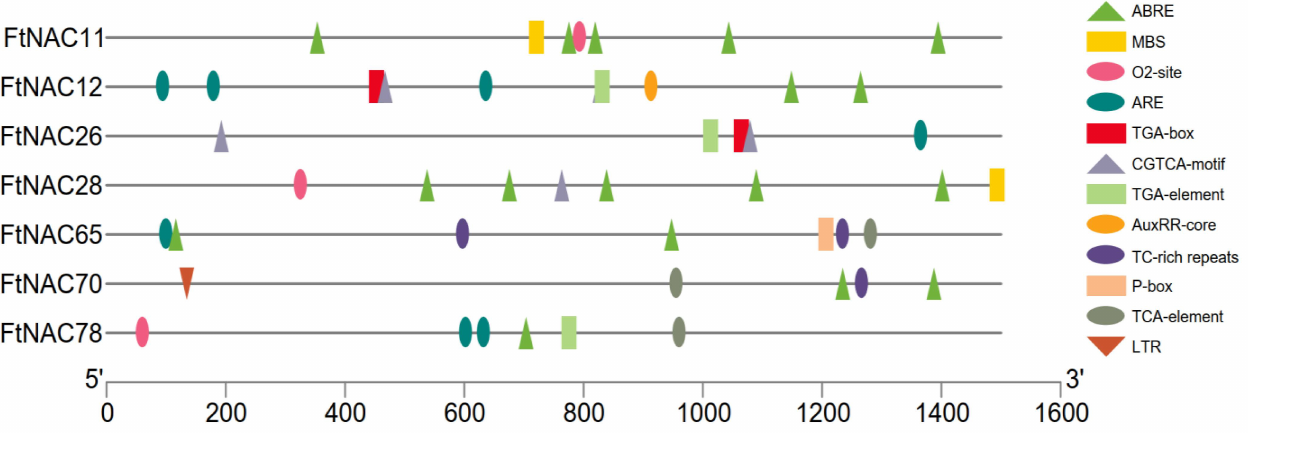
Figure 3. CARE Analyses of Seven FtNAC Promoters. ABRE, CARE involved in the ABA respon- siveness; MBS, MYB-binding site involved in drought-inducibility; O 2 -site, CARE involved in zein metabolism regulation; ARE, CARE essential for the anaerobic induction; TGA-box, part of an auxin- responsive element; CGTCA-motif, CARE involved in MeJA-responsiveness; TGA-element, auxin- responsive element; AuxRR-core, CARE involved in auxin responsiveness; TC-rich repeats, CARE involved in defense and stress responsiveness; P-box, GA-responsive element; TCA-element, CARE involved in salicylic acid responsiveness; LTR, CARE involved in low-temperature